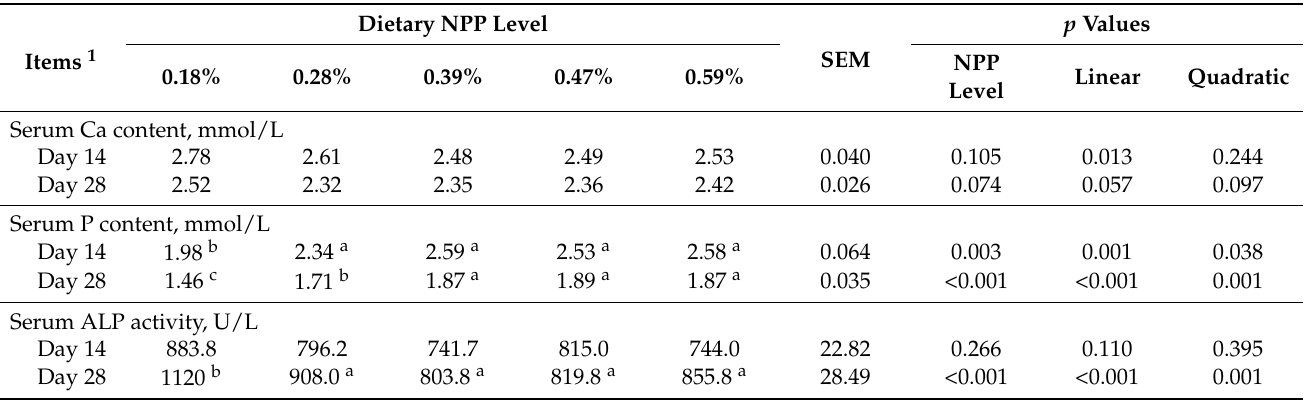
Table 3. Effects of dietary non-phytate phosphorus (NPP) levels on serum variables of goslings at 14 and 28 days of